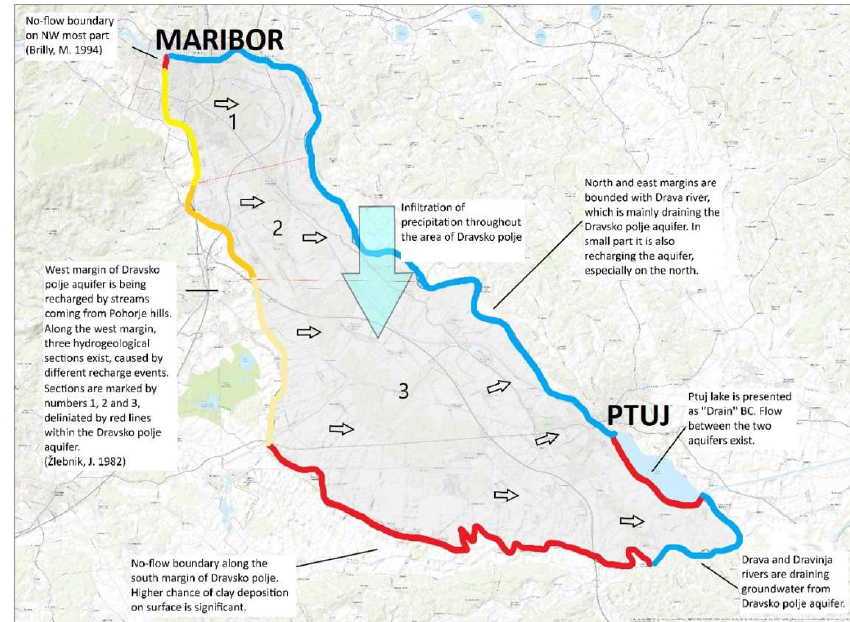
Figure 5. Conceptual model of the Dravsko polje aquifer, Žlebnik, L. [26], Brilly, M. [37].